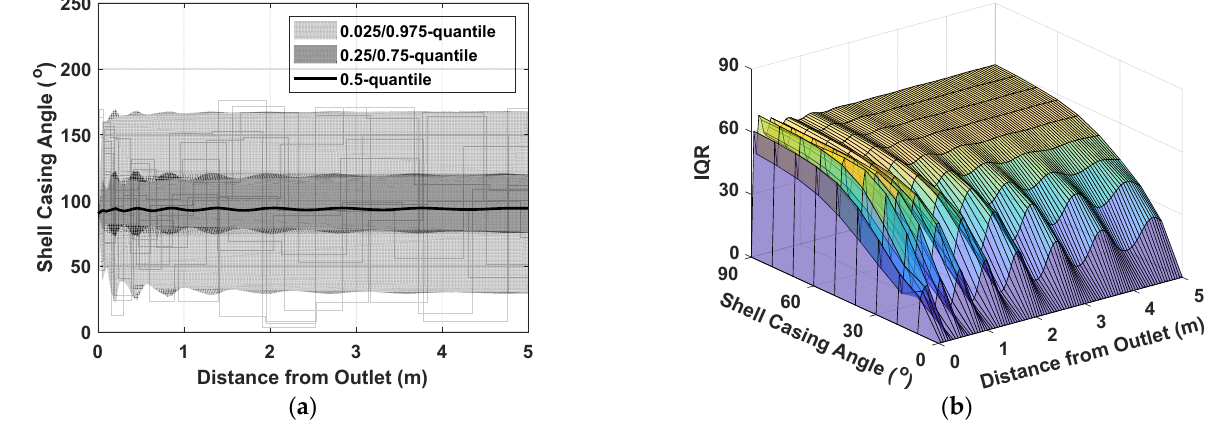
Figure 12. ( a ) Angular perturbations of ejected shell cases and ( b ) interquartile range (IQR). Over the past decade (from 2011 to 2020), the F ‐ 5F type aircraft fired almost one mil ‐ lion 20 mm shells. Two problematic cases were reported during the same period. One of